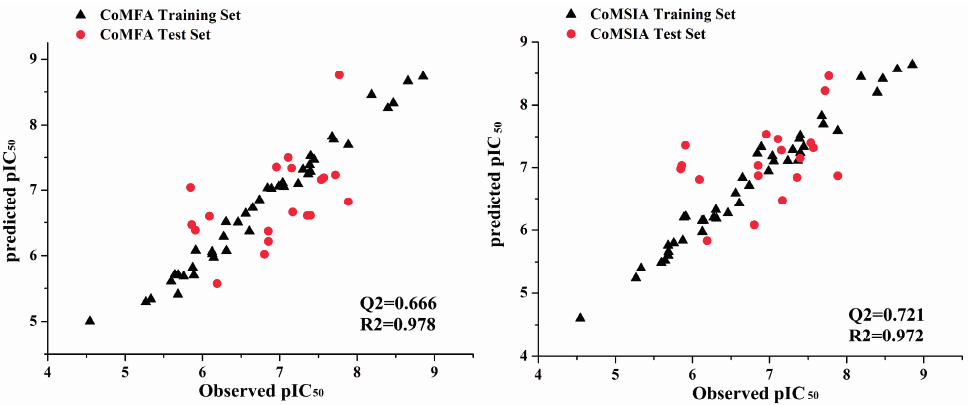
Figure 3. Observed versus predicted pIC 50 values of both training and test sets using CoMFA and CoMSIA in 3D-QSAR